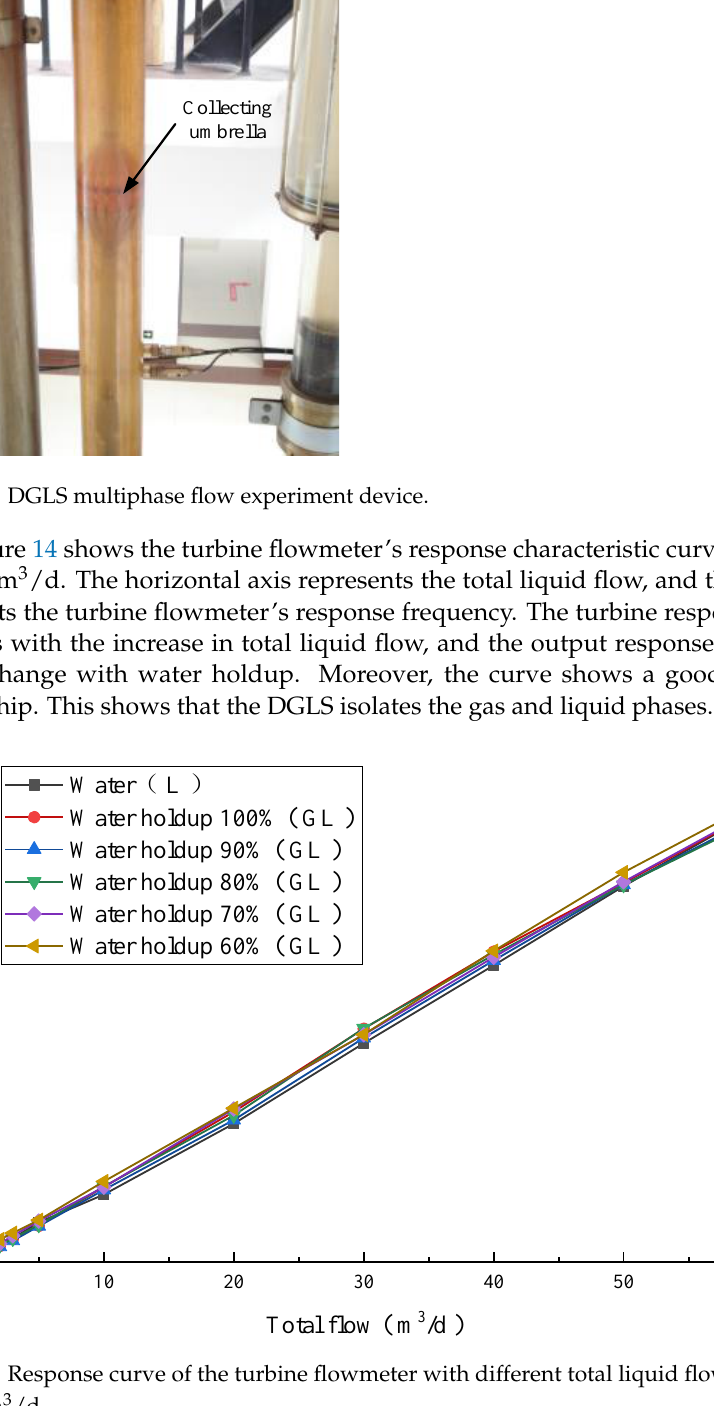
Figure 13. DGLS multiphase flow experiment device.